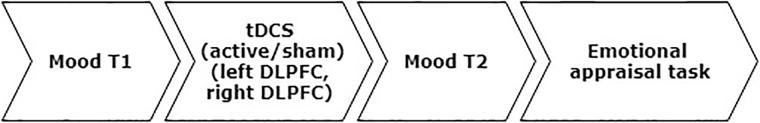
Session protocol.